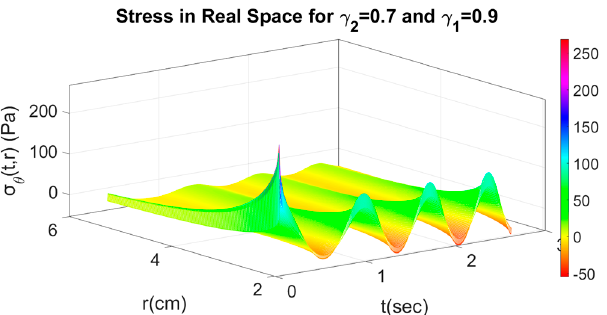
Figure 16. Distribution of the radial stress 𝜎 (cid:3045) (𝑡, 𝑟) in the initial space with space (porosity) fractional order γ 1 = 0.9 and time fractional order γ 2 = 0.7.